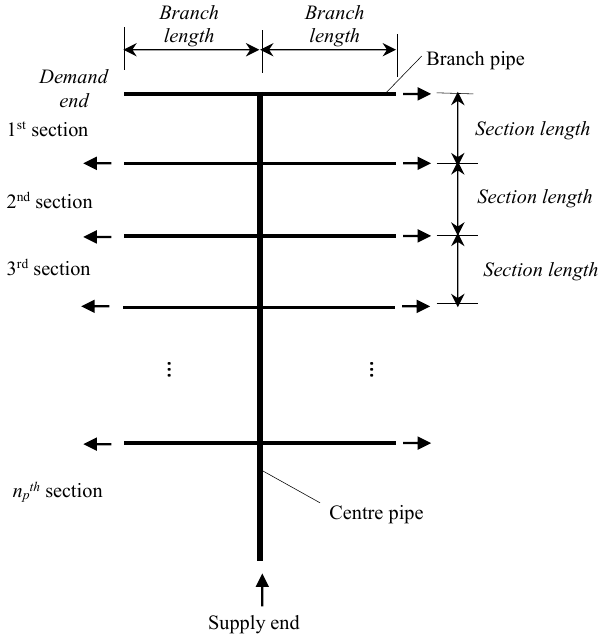
Figure 10. A tree-shaped piping network (A n p -section T-shaped piping network).